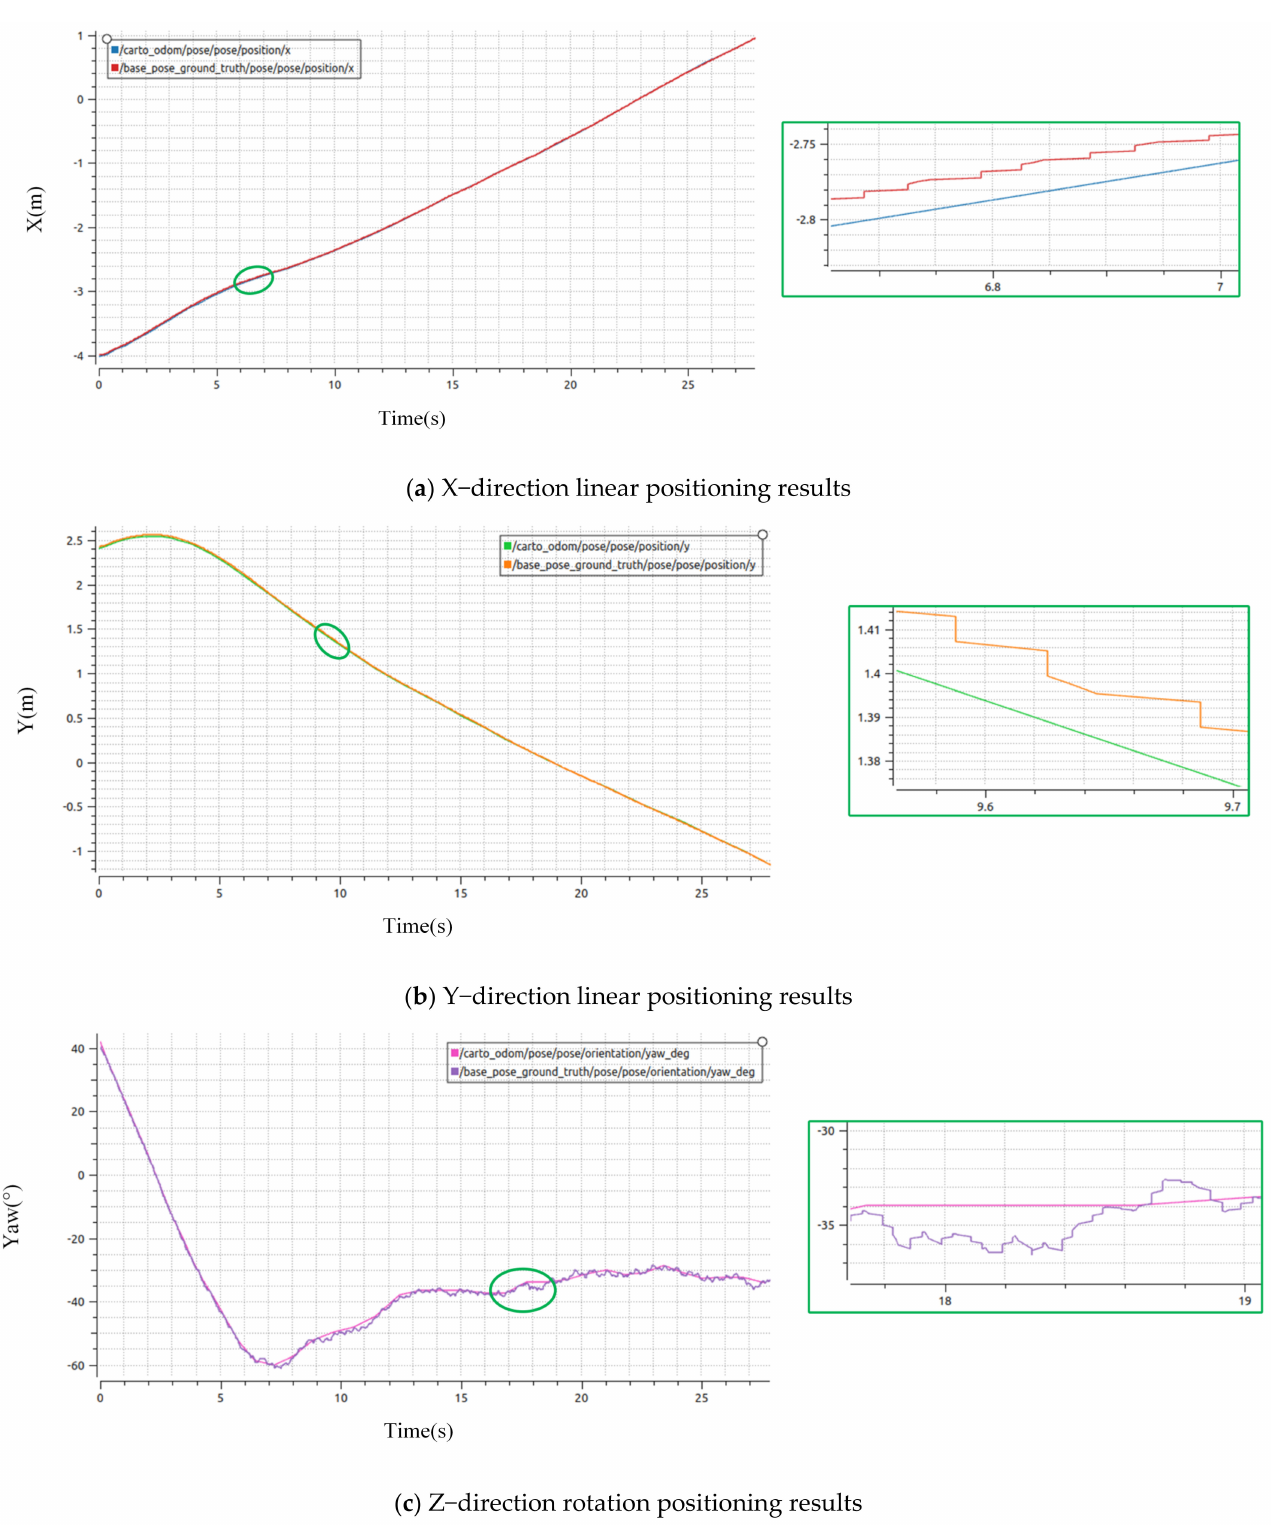
Figure 14. Results of the third group of cartographer simulation positioning